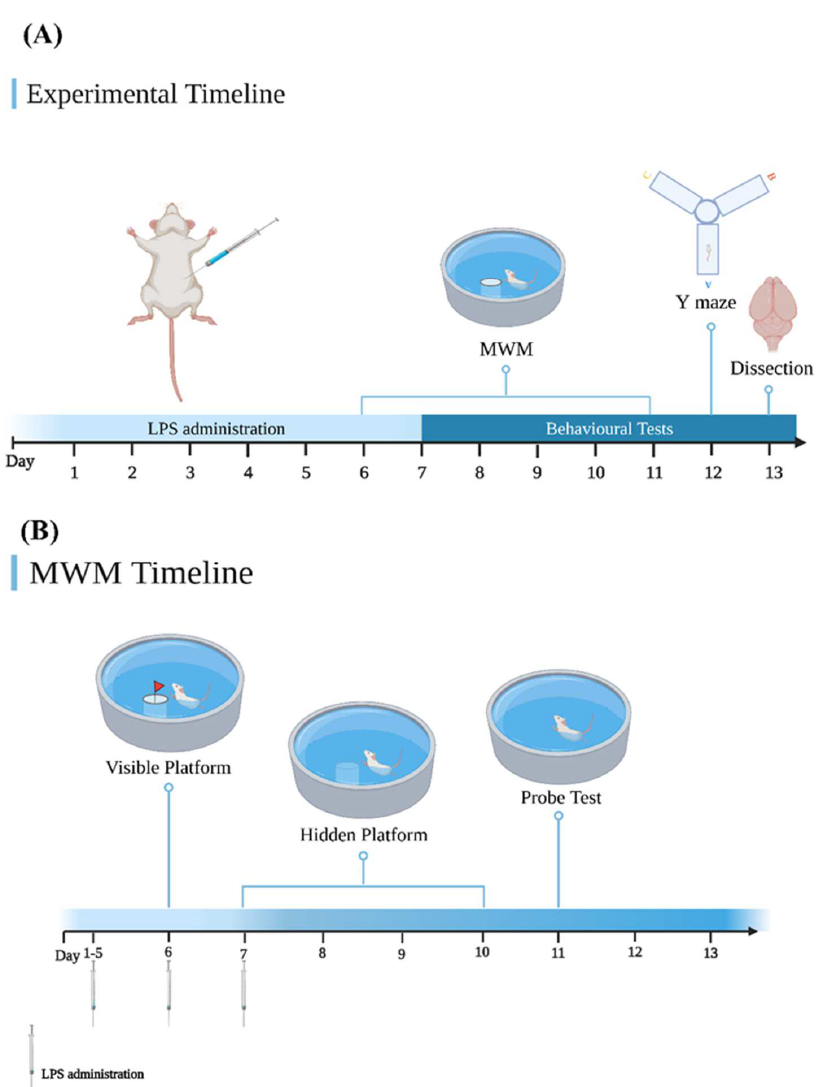
Figure 1. Experimental timeline. ( A ) Experimental timeline and behavioral test summary. The study was conducted for 13 days. LPS was administered on the first 7 days, and behavioral tests were started on the sixth day of LPS administration. At the end of day 13, mice were sacrificed for further histological investigation. ( B ) Timeline of the MWM test. The MWM test was conducted for 6 days starting on the last 2 days (day 6 and 7) of LPS administration. Three stages were preformed: visible platform, hidden platform, and the probe test. MWM: Morris water maze; LPS: lipopolysaccharide. Created with BioRender.com (accessed on 3 June